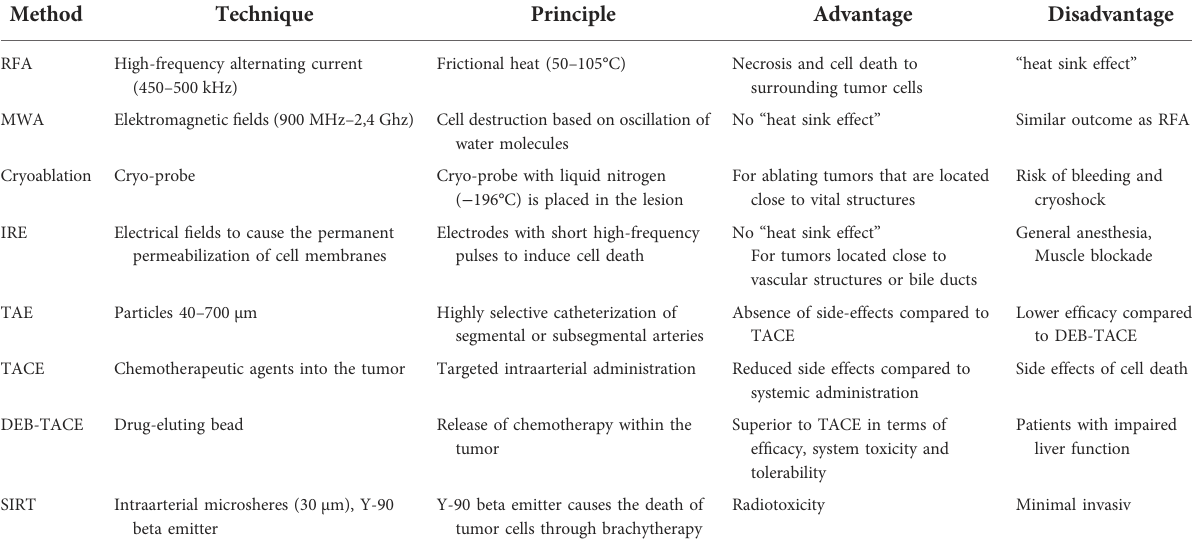
TABLE 1 Overview of locoregional treatments, their principles, advantages and disadvantages. Locoregional